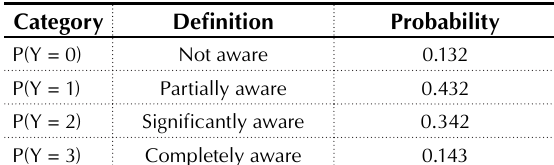
Table 3. Probability distribution of the categories of awareness extent